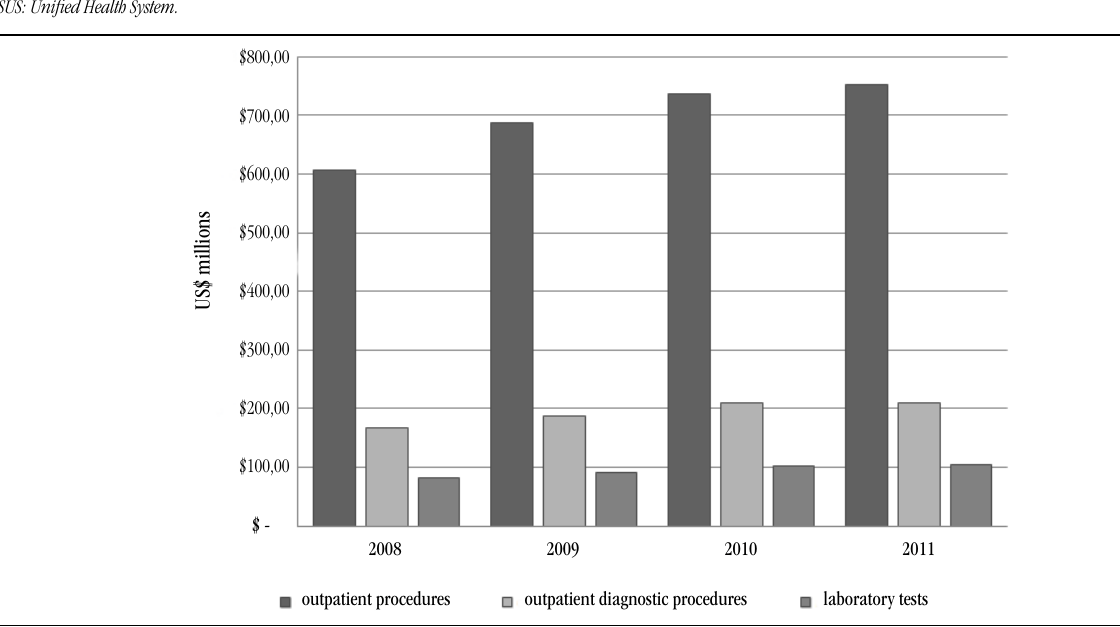
figurE 2 – The evolution of SUS expenses on outpatient procedures in Minas Gerais, 2008-2011 (US$ million) Source: DATASUS, 2012 (12) . SUS: Unified Health